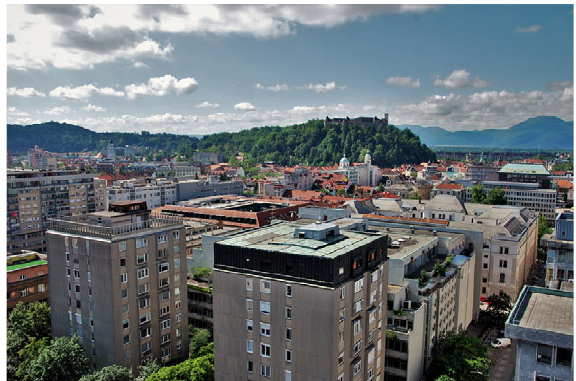
Fig. 4. The centre of Ljubljana was built on the bank of Ljubljanica River at the foot of Castle Hill (photo: J.